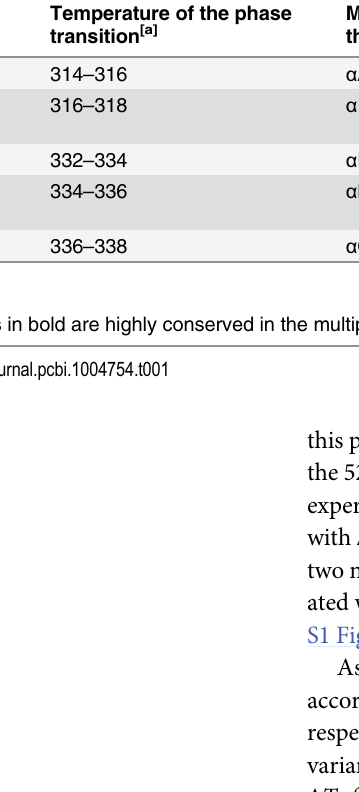
50 compared to WT. − T p (variant) p (WT); in °C.